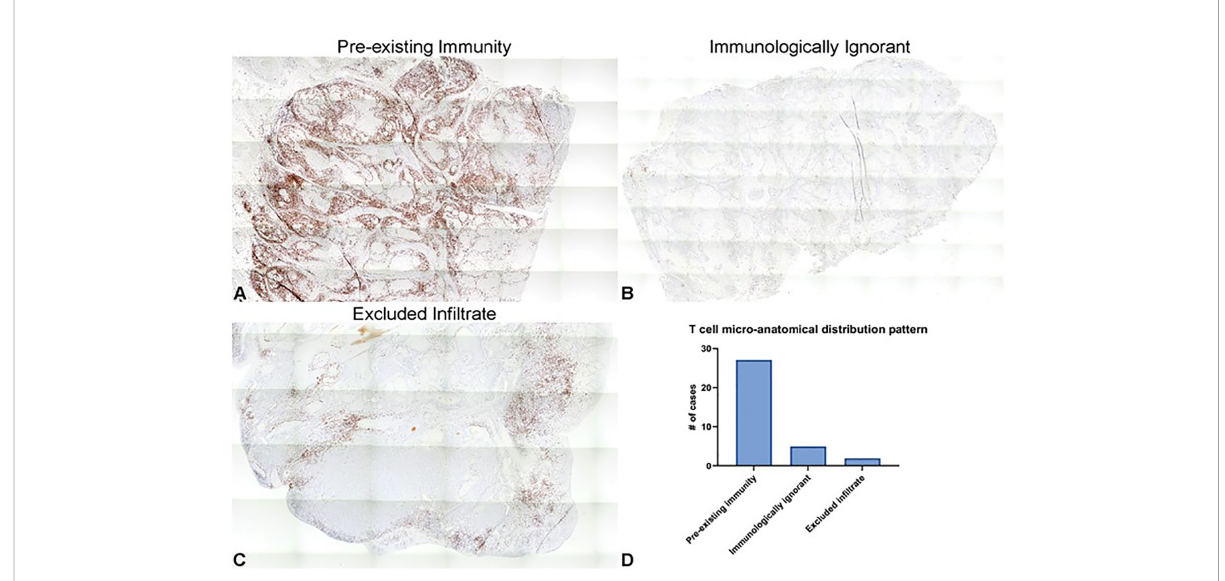
FIGURE 2 Distribution patterns of CD3+ tumor-in fi ltrating T cells in canine OSCC represent those observed in human cancers. (A – C) Representative photomicrographs of the three different CD3+ cellular in fi ltration patterns observed in our subset of cases, including “ pre-existing immunity ” (A) , “ immunologically ignorant ” (B) , and “ excluded in fi ltrate ” (C) . 5x magni fi cation. (D) Quanti fi cation of the number of tumor samples characterized as each of the relative densities of T cell micro-anatomical distribution